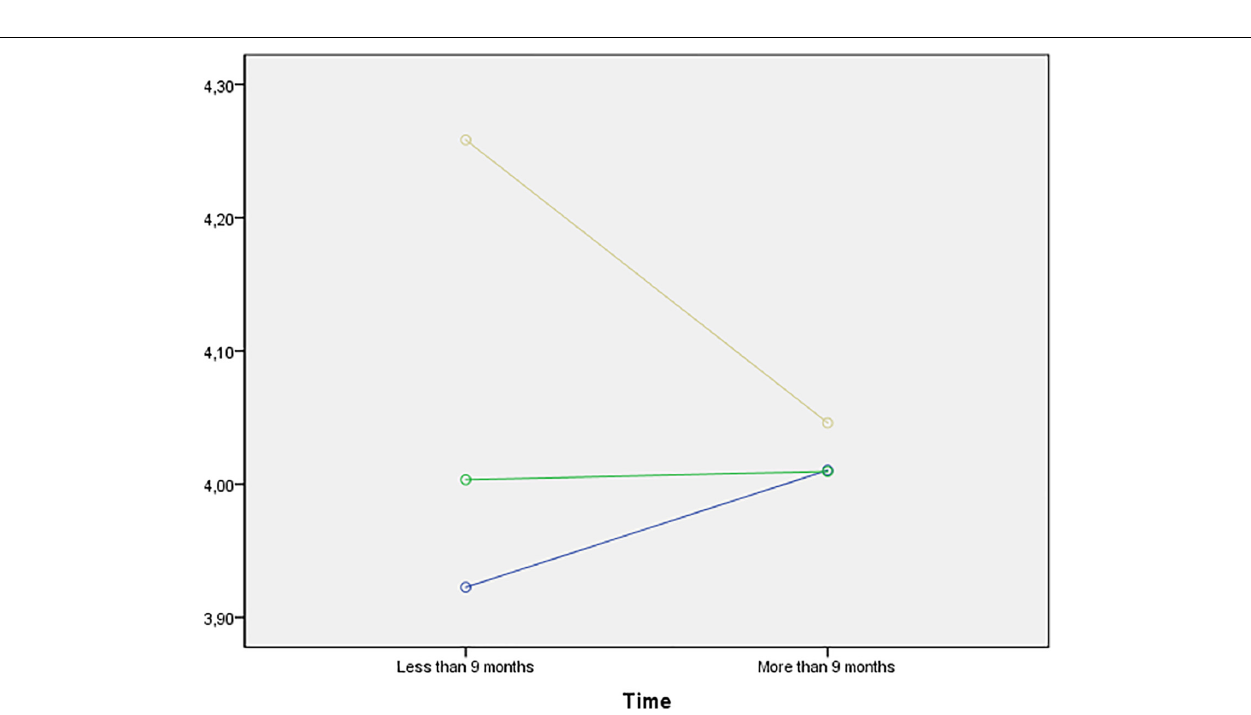
FIGURE 2 | Mean values of effort (factor 2) by educational level and length of residence. Note: Blue (Primary Education; Green (Secondary Education); Yellow (Baccalaureate—Vocational Training).